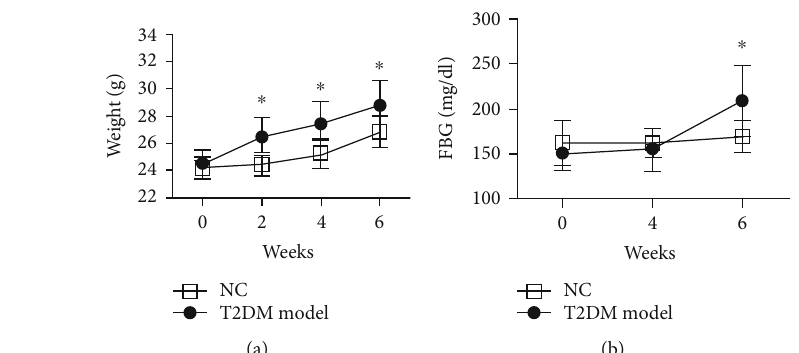
Figure 2: Comparison of weight and FBG between NC and T2DM groups. Body weight of T2DM mice increased signi fi cantly after HFD feeding for two weeks (a). FBG was elevated in the T2DM group after STZ injection for two weeks (b) (data presented as mean ± SEM . ∗ P < 0 : 05 vs. NC mice, n = 5